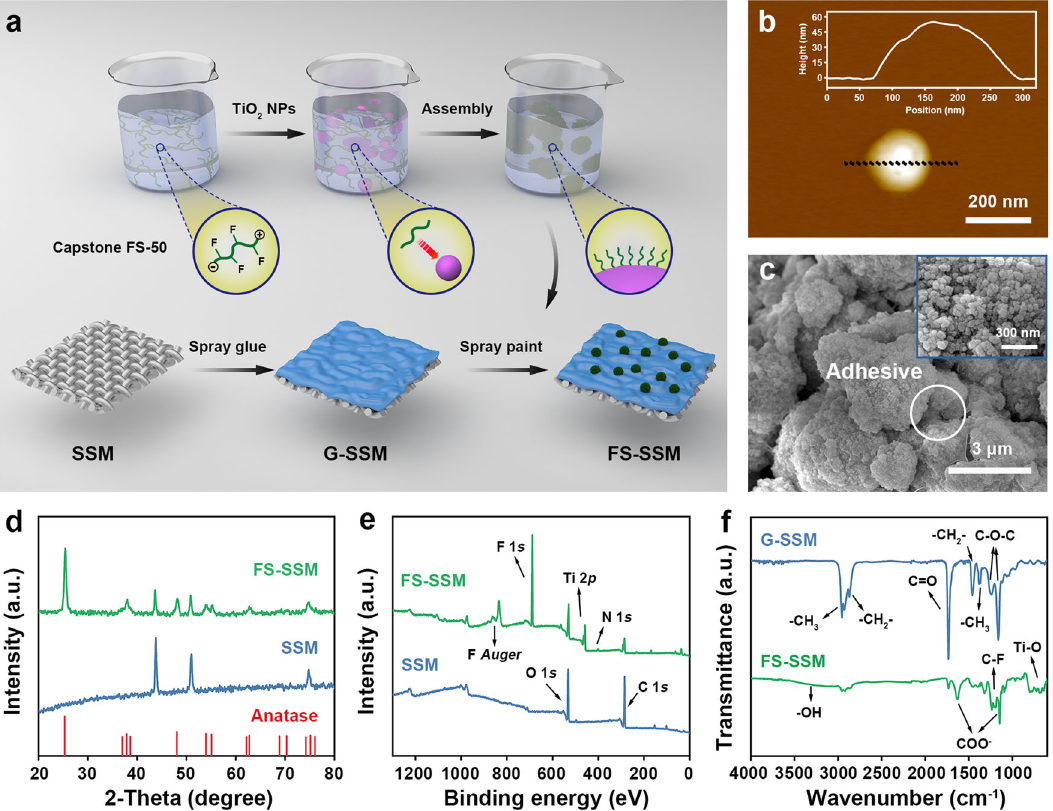
Fig. 2 Fabrication process and characterizations of recon fi gurable membranes. a Schematic diagram of the preparation procedures (G-SSM represents the polyacrylate glue-coated SSM). b AFM images with height pro fi le along the dotted line. c SEM images of the as-prepared membrane showing the hierarchical microstructures. d XRD pattern of FS-SSM and untreated SSM substrate compared with the respective standard patterns of TiO 2 anatase. e XPS wide spectra of FS-SSM and SSM, where “ F ” and “ N ” refer to the Capstone FS-50, and “ Ti ” refers to TiO 2 . f FTIR spectra of the membranes in different preparation